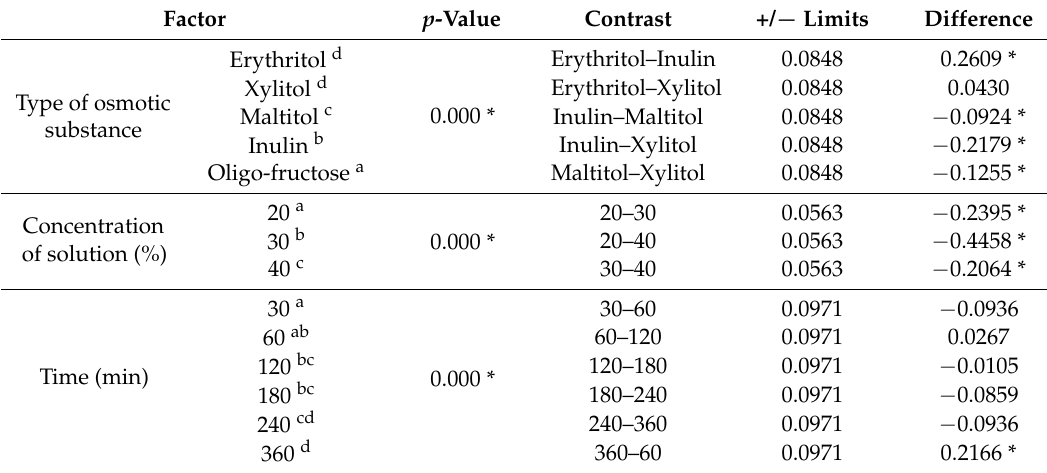
Table 7. The influence of osmotic pre-treatment in different types, concentrations of solutions, and time on SG (g/g i.d.m.) during OD. Factor p